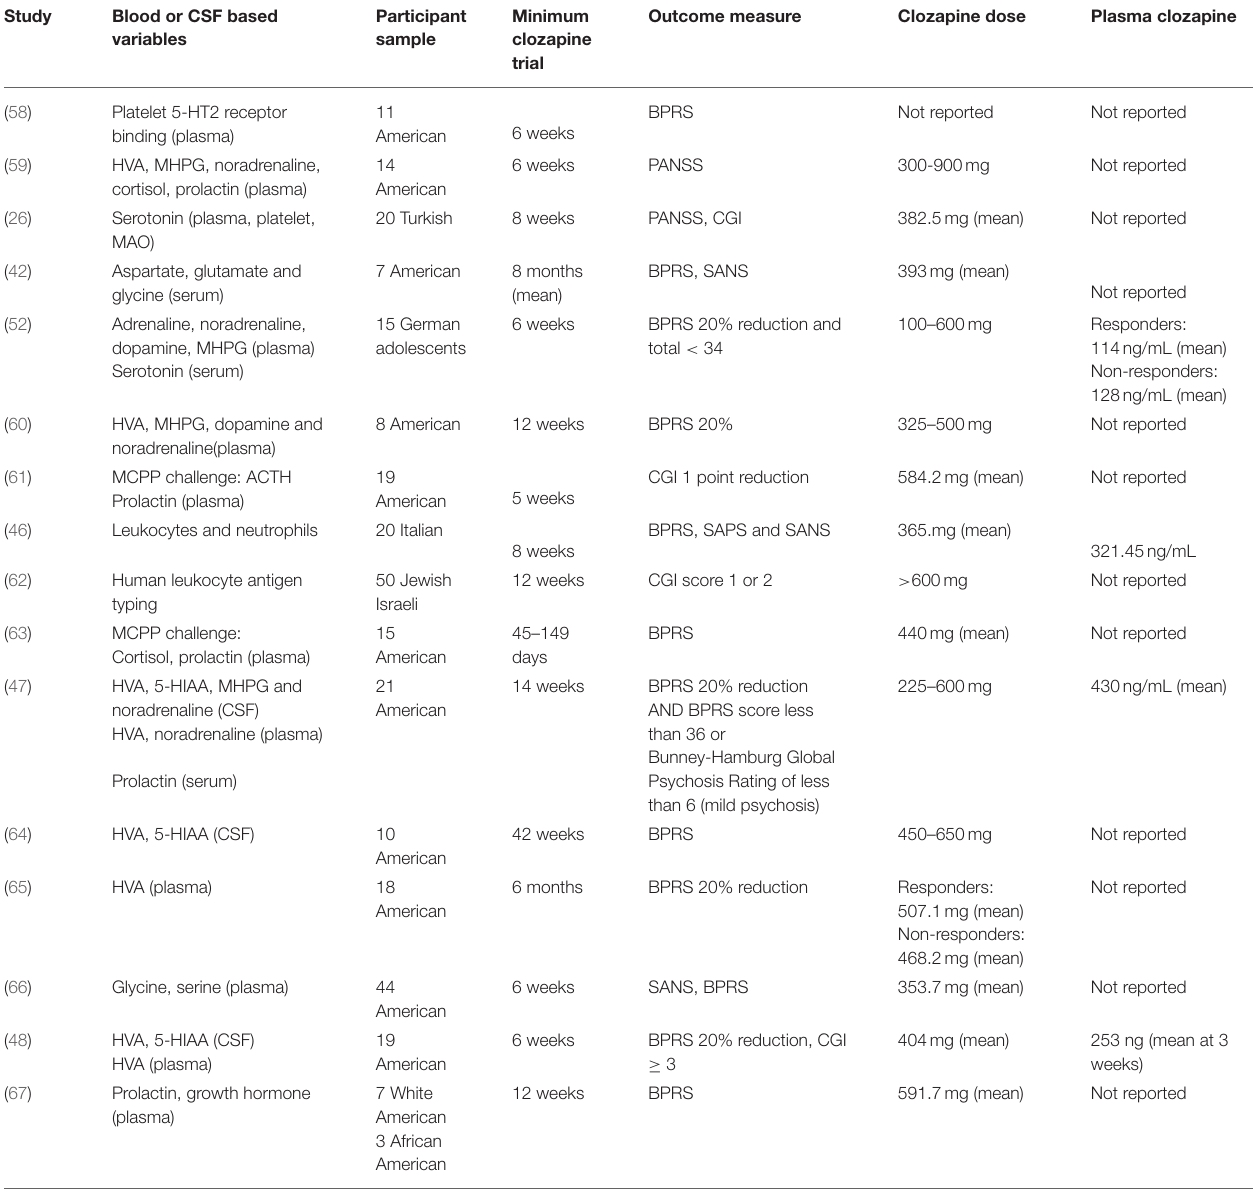
TABLE 4 | Included blood or CSF-based